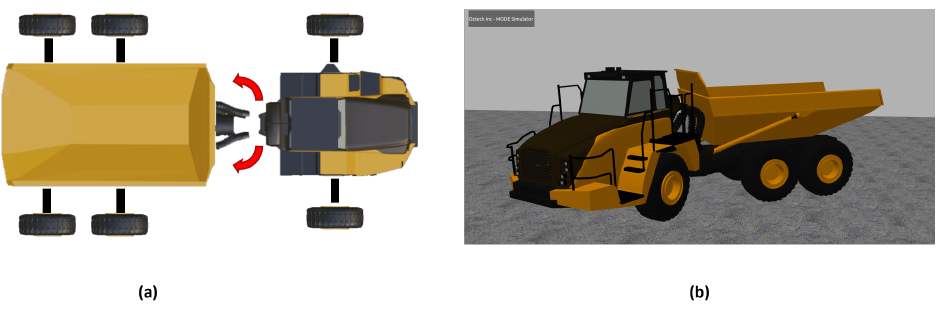
Figure 5. Construction of the articulated truck model. ( a ) shows the rigid-body construction of the articulated dump truck. Suspension joints at the wheels were modeled as prismatic joints. ( b ) shows the articulated dump truck model in